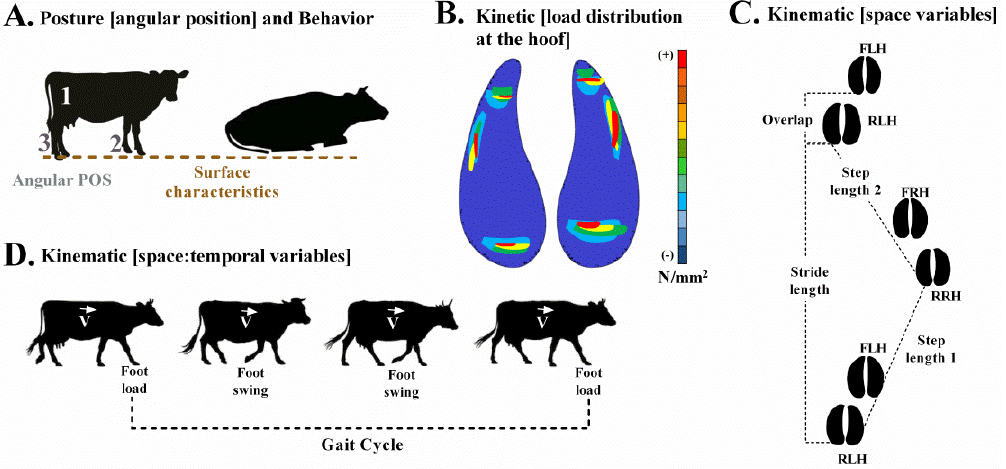
Figure 1. Schematic view of animal posture, behavior, kinetic, and kinematic parameters. ( A ). Pos- ture and behavior analysis. Behavior is evaluated in two phases. First, when the animal is in a standing position, three posture parameters are recorded: (1) hip angle position relative to the back, (2) joint angle at the wrist, and (3) joint angle at the ankle. Second, measurements were taken as the time budget used for lying down in a resting position against the time standing up (hours per day). ( B ). Kinetics are estimated by the load distribution through the whole hoof. This could be measured with a force platform or modeled using a computer simulation (Finite Element Analysis), both expressed as Von Misses stress (N/mm 2 ) (illustrative image modified from Hinterhofer et al., 2005) [16]. ( C ). Kinematics of the stride are characterized by its length (distance of one gait cycle, in meters), step length (distance between the hind or anterior right leg vs. the left, in meters), and anterior vs. posterior leg overlap, which, if positive, indicates that during a stride, the advance of the anterior limb in relation to the posterior limb on the same side is greater than 0 cm. FLH: front left hoof; RLH: rear left hoof; FRH: front right hoof; RRH: rear right hoof (modified from Telezhenko, 2009) [11]. ( D ). Kinematics of the gait cycle are established by the gait speed (distance per unit of time, in m/s), the cadence (steps per unit of time, in steps/s), and the time of the support and balancing phases during the gait cycle. Source: own illustration based on the articles cited.